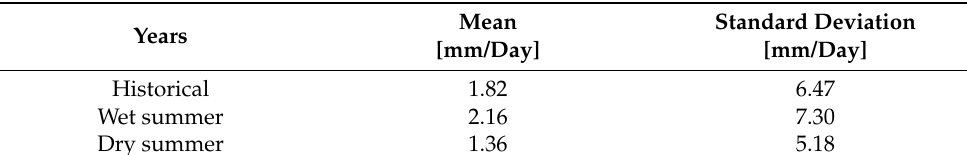
Figure 3. Spatial distribution of seasonal precipitation [mm/day] in the Shell Creek watershed be- tween 2002 and 2013 for ( a ) winter, ( b ) spring, ( c ) summer, and ( d ) fall. Data were obtained from NEXRAD. Table 3. Shell Creek seasonal mean precipitation in years with extreme hydrometeorological and climate conditions.